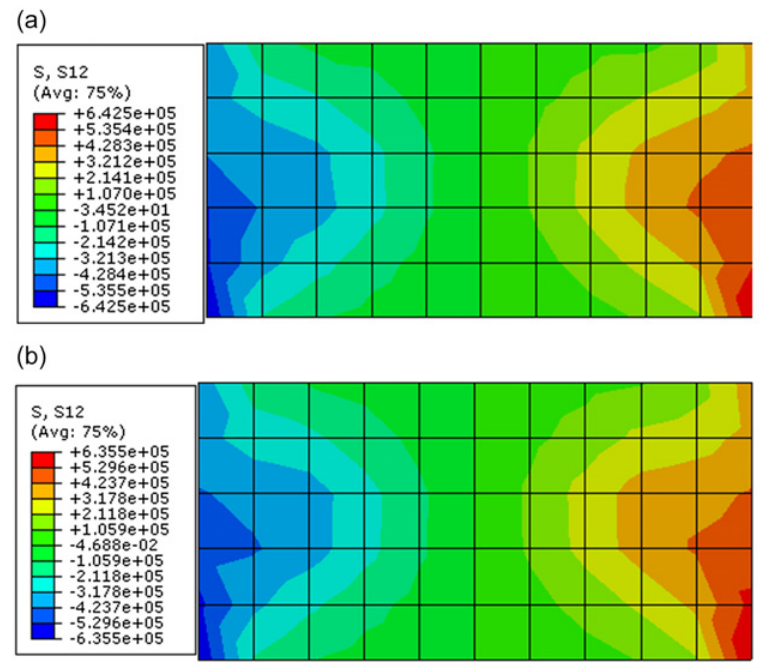
Fig 17. The shear stress contour of the rectangle beam calculated by different constitutive models (Pa) ((a) The shear stress contour calculated by proposed constitutive model; (b) The shear stress contour calculated by ubiquitous-joint model)